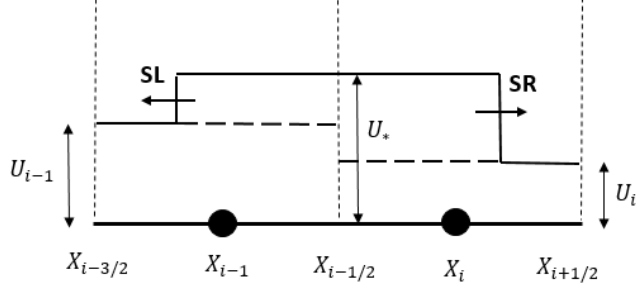
Figure 1. Wave structure at the Harten, Lax, and van Leer (HLL) solver .